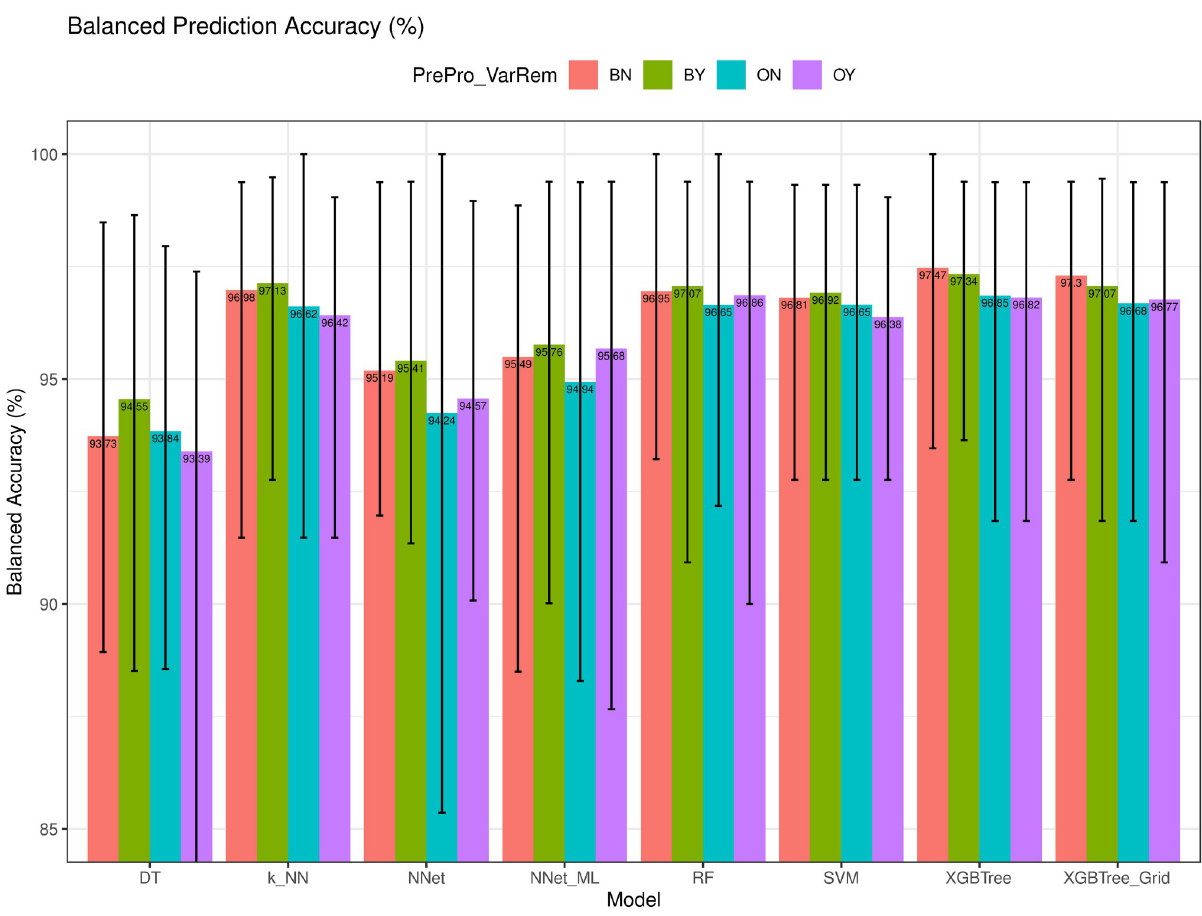
Fig 9. Balanced accuracy ( bAcc ) of different